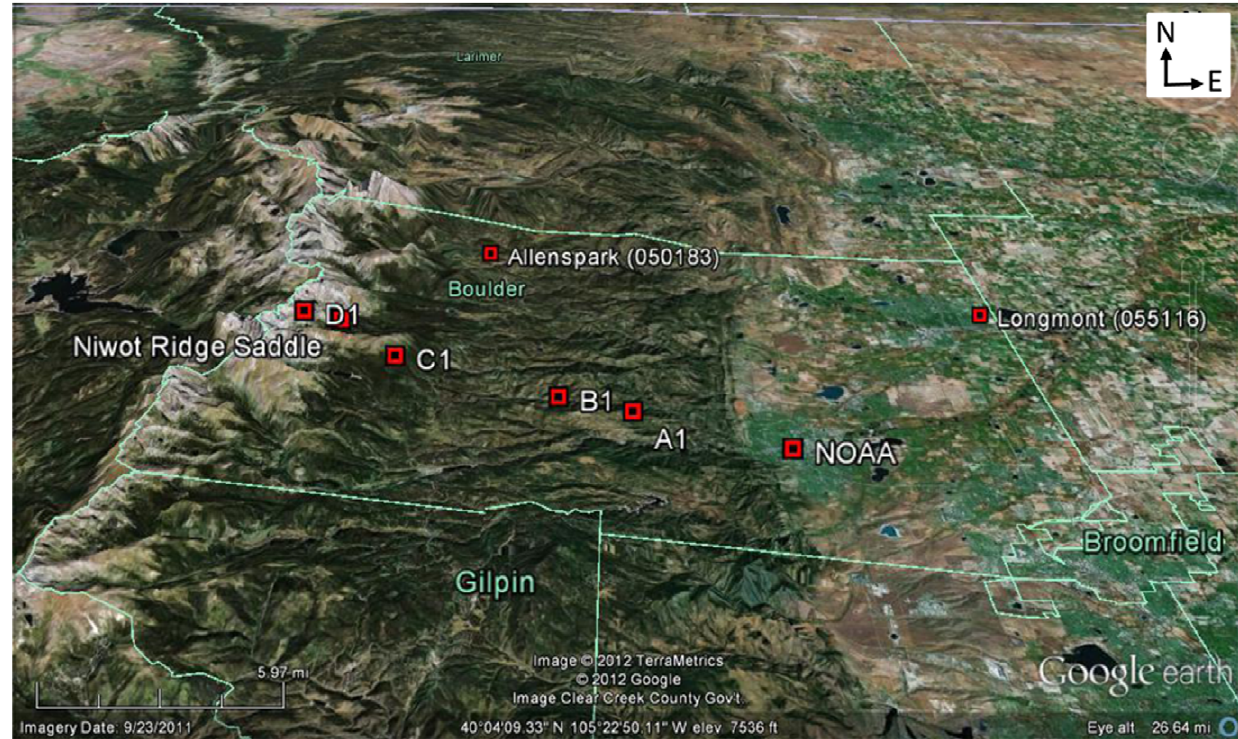
Figure 1. Topographic relief map showing locations of RMFR transect and important stations used for infilling and data correction (Denver station not shown).